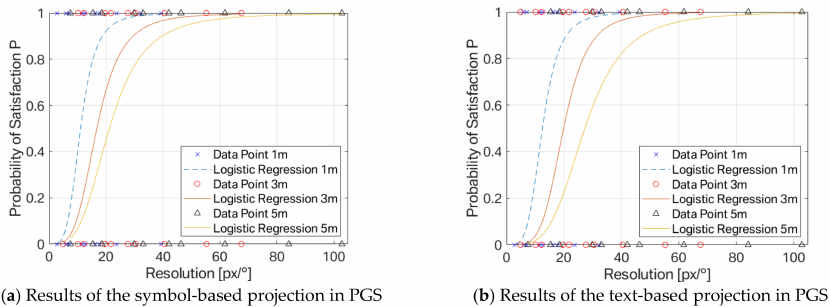
Figure 4. Results of the analyzed data by using the logistic regressing Equations (3) and (4) for extract- ing the 90% threshold for the resolution in px/ ◦ with the corresponding probability of satisfaction in the PGS. ( a ) Detailed illustration of the logistic regression of the symbol-based projection in the PGS, including the raw data, which is marked with “X” for 1 m data, with circles for 3 m data and triangles for 5 m data; ( b ) Detailed logistic regression of the text-based projection in the PGS including the raw data, which is marked with X for 1 m data, with circles for 3 m data and triangles for 5 m